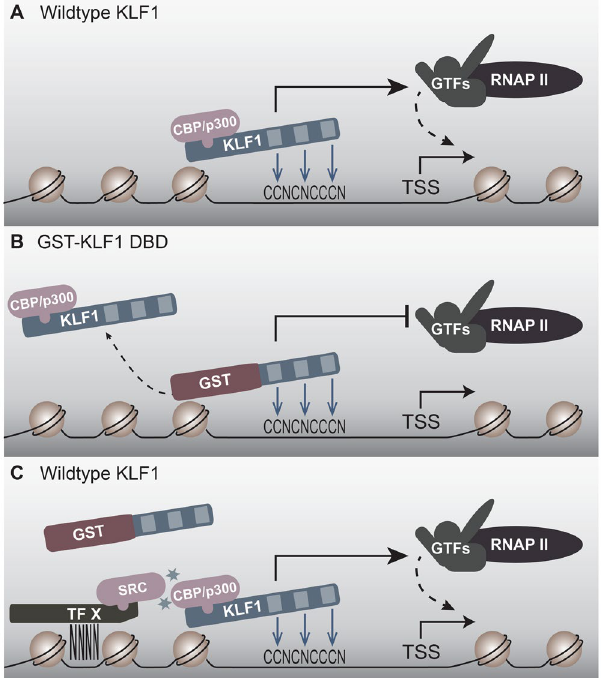
Figure 5. GST-KLF1 DBD can act as a dominant negative at some KLF1 target sites to displace endogenous KLF1 binding, thereby inhibiting DNA activation. ( A ) In the absence of GST-KLF1 DBD, endogenous KLF1 is able to bind and activate its target genes normally. ( B ) At some KLF1 target sites, for instance the Klf3 1b promoter, the GST-KLF1 DBD protein is able to out-compete endogenous KLF1, either by sheer amount of protein present, or a higher affinity for the site. This results in reduced activation of these target genes. ( C ) At some sites, GST is unable to bind due to it not being able to interact efficiently with other KLF1 partners and SRC family members. In this case, activation of KLF1 target genes in